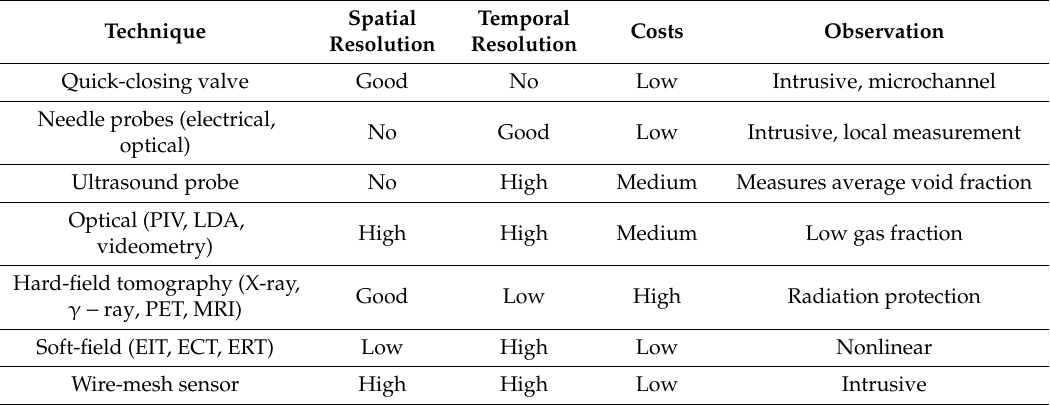
Table 2. Methods comparison.